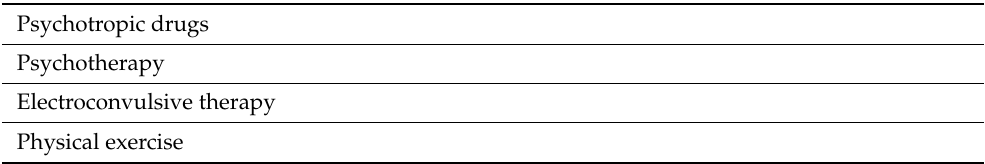
Table 2. Environmental factors interacting epigenetically with the genome to reverse psychi- atric